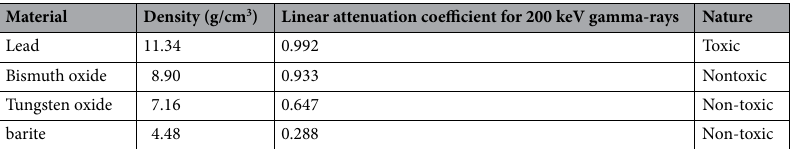
Table 1. Properties of common materials for radiation shielding